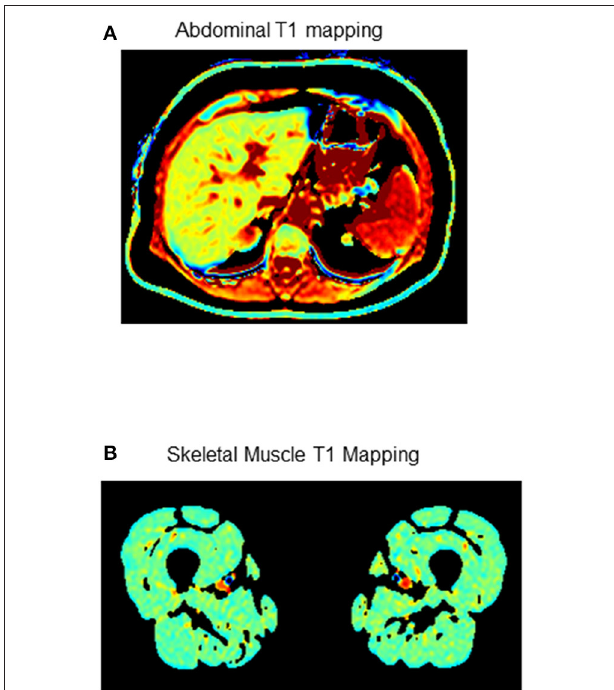
FIGURE 4 | Examples of MRI T1 mapping sequences to assess the extra-cardiac effects of exercise training in patients with or at risk for cardiovascular disease. (A) Abdominal fat density (B) Skeletal muscle fat compartments. Dark signal = fat.